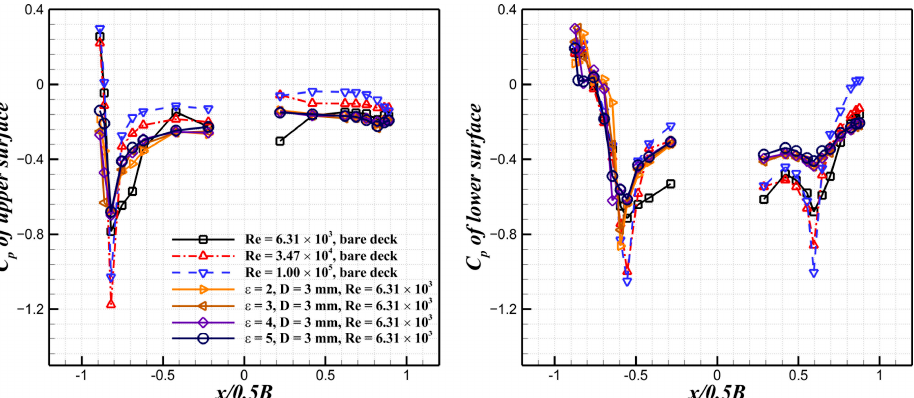
Figure 12. Comparisons of the time-averaged surface pressure distribution of the twin-box girder with circular cylinder interference and bare deck.